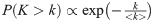
A, B, C: Degree distribution of the three subnetworks.A’, B’, C’: Node strength distribution of the three subnetworks. The distribution of the nodes strength follows a stretched exponential function of type P(K > k) = exp((−λk)α). The inset figures show the evolution of the average degree < k > (B and C) and the α parameter evolution of the stretched exponential equation (A’,B’,C’). A. Degree distribution of the backbone subnetwork. The degree distribution follows a power law of type P(K > k) ∝ k−α). The values for 2013 are kmin = 7 and α = 1.83 and the Kolmogorov-Smirnov statistic is: Dn = 0.077. As the α parameter is less than 2.0, the standard deviation and the mean (< k >) are undefined. The hubs are Belgium, USA, France, The Netherlands, Italy, Germany and United Kingdom. A’. Node strength distribution of the backbone subnetwork. The stretched exponential distribution and its α parameter are stable in time. B. Degree distribution of the intermediate subnetwork. The cumulative density function fits with an exponential function of type P(K>k)∝exp(-k<k>). In 2013, the average nodes degree is < k > = 51.67 and the correlation coefficient is R2 = 0.99. B’. Node strength distribution of the intermediate subnetwork. The stretched exponential distribution changes over time as shown by the decrease and stabilization of the α parameter. C. Degree distribution of the transient subnetwork. The degree distribution of the transient subnetwork fits with an exponential function. In 2013, the average node degree is < k > = 11.98. The correlation coefficient is R2 = 0.97. C’. Node strength distribution of the transient subnetwork. The evolution in time of the stretched exponential distribution is erratic as shown by the random changes in the α parameter.